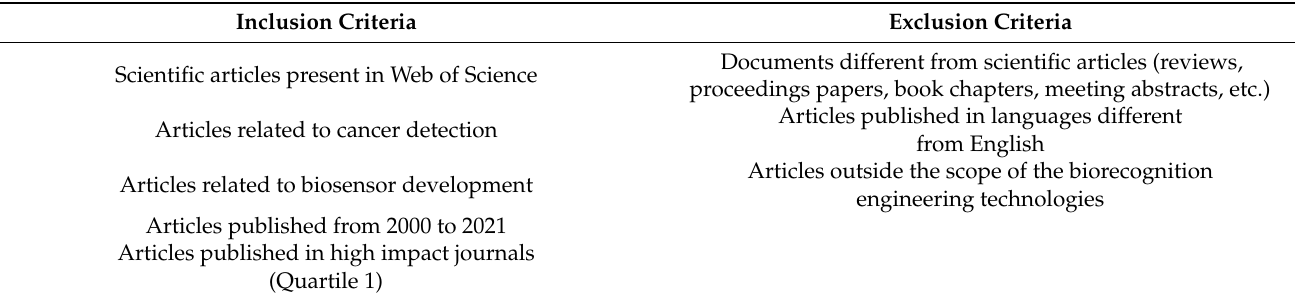
Table 2. Inclusion and exclusion